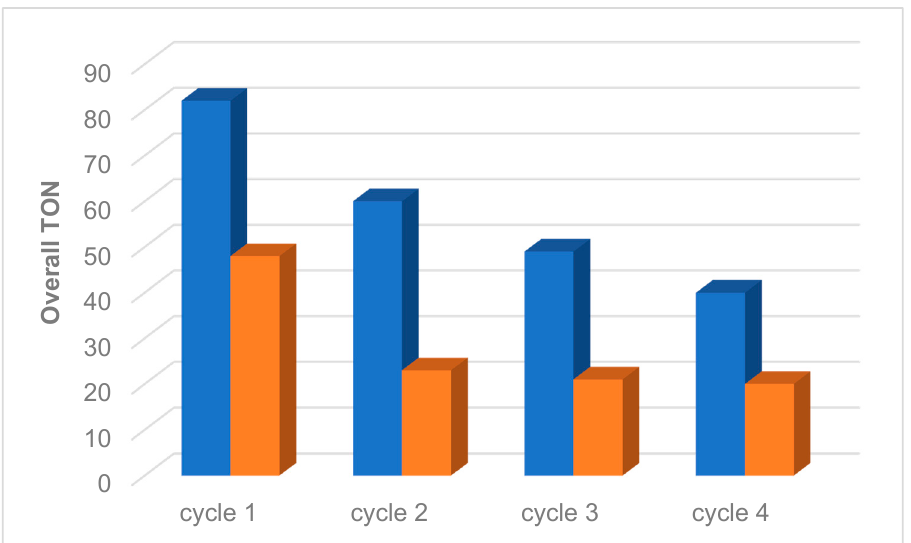
Figure 2. Effect of catalyst recycling on the overall TON of the product for the MW-assisted synthesis of 1,2,3-triazole catalyzed by 2 _CNT-ox-Na ( (cid:4) ) and 4 _CNT-ox-Na ( (cid:4) ). Reaction conditions: 0.5 mol% of 2 _CNT-ox-Na vs. benzyl bromide, 1.0 mol% of 4 _CNT-ox-Na vs. benzyl bromide, 15 min, 30 W microwave irradiation, 80 °C.